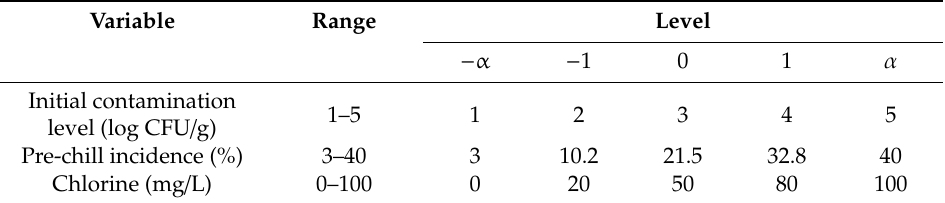
Table 1. Levels of variables in the experiment.